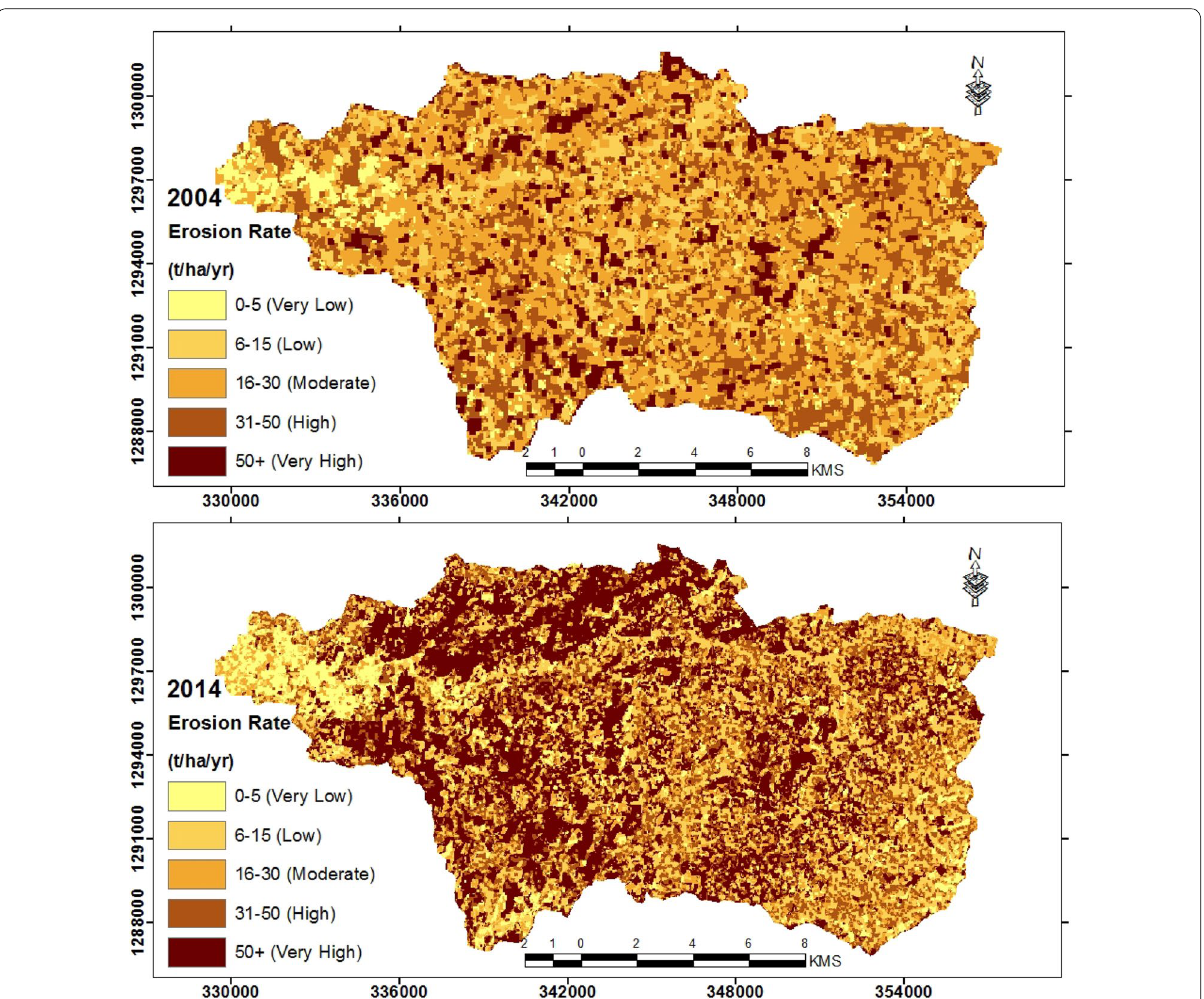
Fig. 9 Spatial distributions of potential annual soil loss and severity classes at Gelda catchment between 2004 and 2014 (top-down), Northwestern highlands of